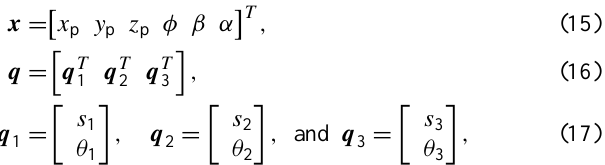
Figure 3. Sketch of a general 3-PRS manipulator.